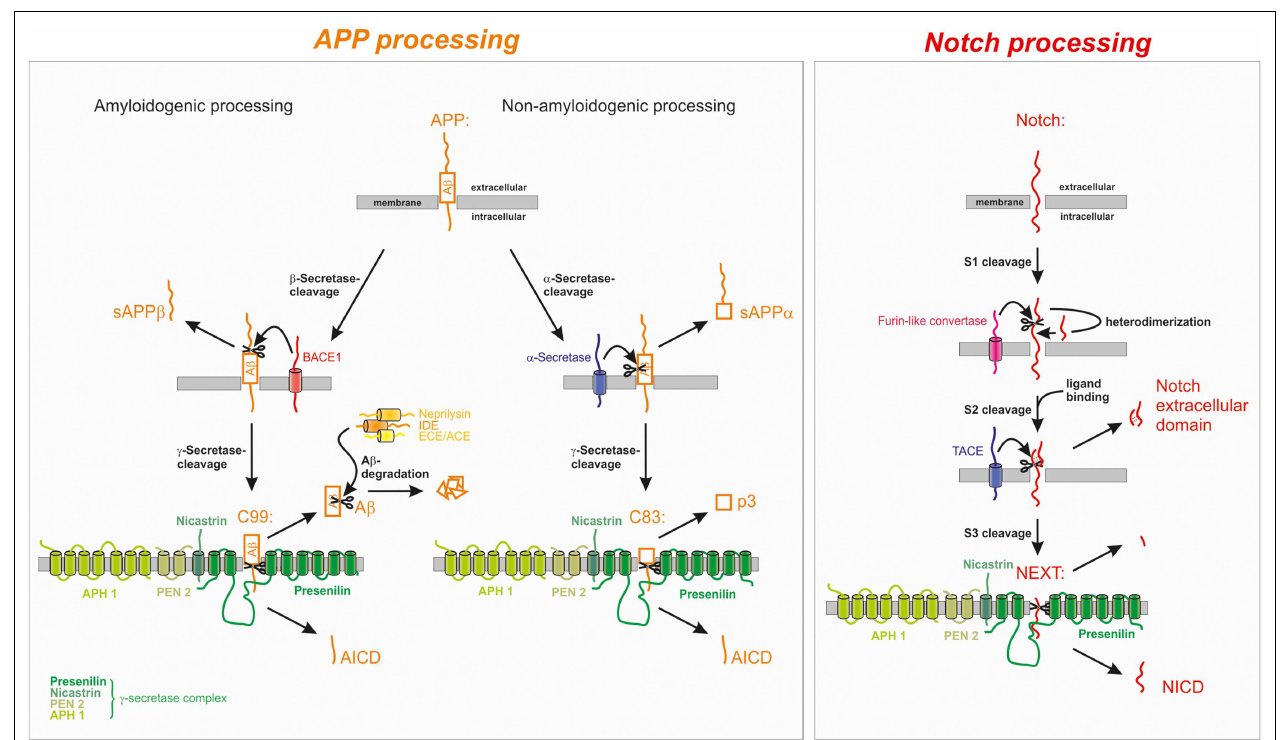
by several enzymes, for example neprilysin (NEP), insulin-degrading enzyme (IDE), endothelin-converting enzyme (ECE), and angiotensin converting enzyme (ACE). In both processing pathways the APP intracellular domain (AICD) is released into the cytosol. Notch processing: after maturation S1 cleavage of the Notch receptor precursor by a furin-like convertase, Notch is processed similarly to APP. Ligand binding triggers the S2 cleavage by the α -secretaseTACE/ADAM17 leading to the release of the Notch extracellular domain into the extracellular space.The remaining membrane-bound fragment Notch extracellular truncation (NEXT) is further processed by the γ -secretase complex resulting in the release of the Notch intracellular domain (NICD) from the